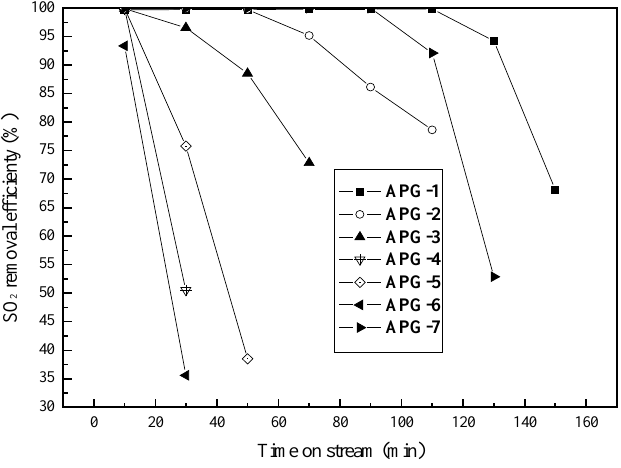
6 Figure 3. FT-IR spectra of the mixed oxides derived from precursors after calcinating at 700 °C. 1: APG-7; 2: APG-2; 3: APG-5; 4: APG-1; 5: APG-3; 6: APG-6; 7: APG-4. Based on the analysis of above physical and chemical properties, desulfurization activity of the composition and performance of sulfur transfer agent with different oxidative active components have been studied after the samples are in 700 °C (Figure 4). It can be seen from Figure 4 that all sulfur transfer agents prepared by different oxidative active components have certain degree of oxidative desulfurization performance and the oxide removal of SO 2 is: APG-1 > APG-7 > APG-2 > APG-3 > APG-5 > APG-4 ≈ APG-6. The reason for significant desulfurization performance of APG-1 is that copper oxide is beneficial to SO